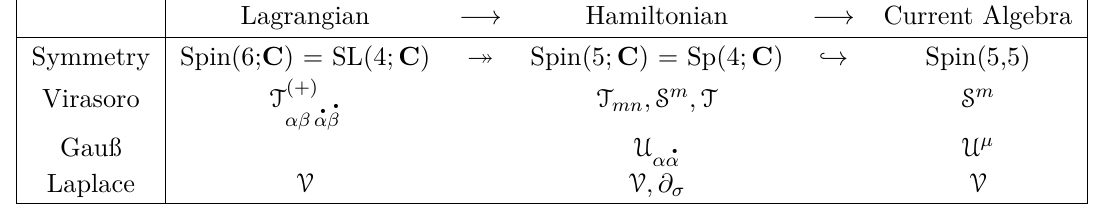
Table 2 . Symmetry breaking and enhancement in the 4D system (rank 5). The Lagrangian description of the dynamics preserves a larger symmetry than the Hamiltonian description but again there is a kinematic subalgebra of the Virasoro+Gauß+Laplace algebra preserving a higher- rank symmetry. (We name the V constraint “Laplace” since it acts as a Laplacian on functions, cf. eqs. (3.12) and (3.13).) Note that in this case the Lagrangian group Spin(6; C ) is not a subgroup of the full symmetry group Spin(5 , 5)